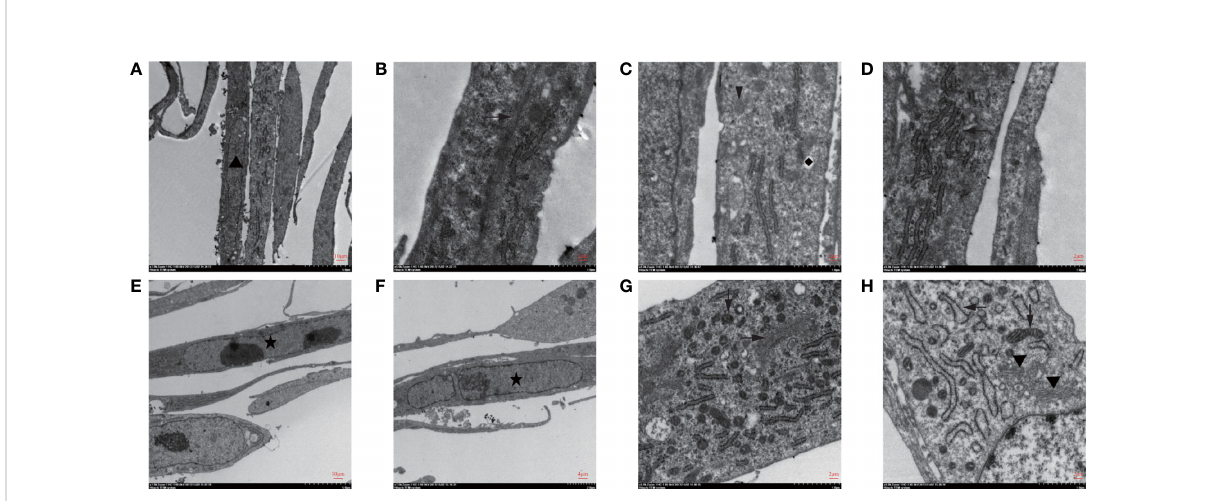
FIGURE 2 Subcellular structure of CAFs changed after irradiation was seen under transmission electron microscopy. (A – D) The observation of the subcellular structure of CAFs before irradiation showed that the nuclei were oval with obvious nucleoli ( ▲ ). Rough endoplasmic reticulum ( ← ), mitochondria ( ↓ ), vesicles ( ◆ ), microtubules ( ! ), and micro fi laments can be seen in the cytoplasm; (E – H) The observation of the subcellular structure of CAFs after 8Gy irradiation revealed double nucleoli and double nuclei ( ★ ) and lobulated nuclei in the nucleus. The rough endoplasmic reticulum increased and expanded, and mitochondria were divided and increased, while Golgi apparatus ( ▼ ) increased in the